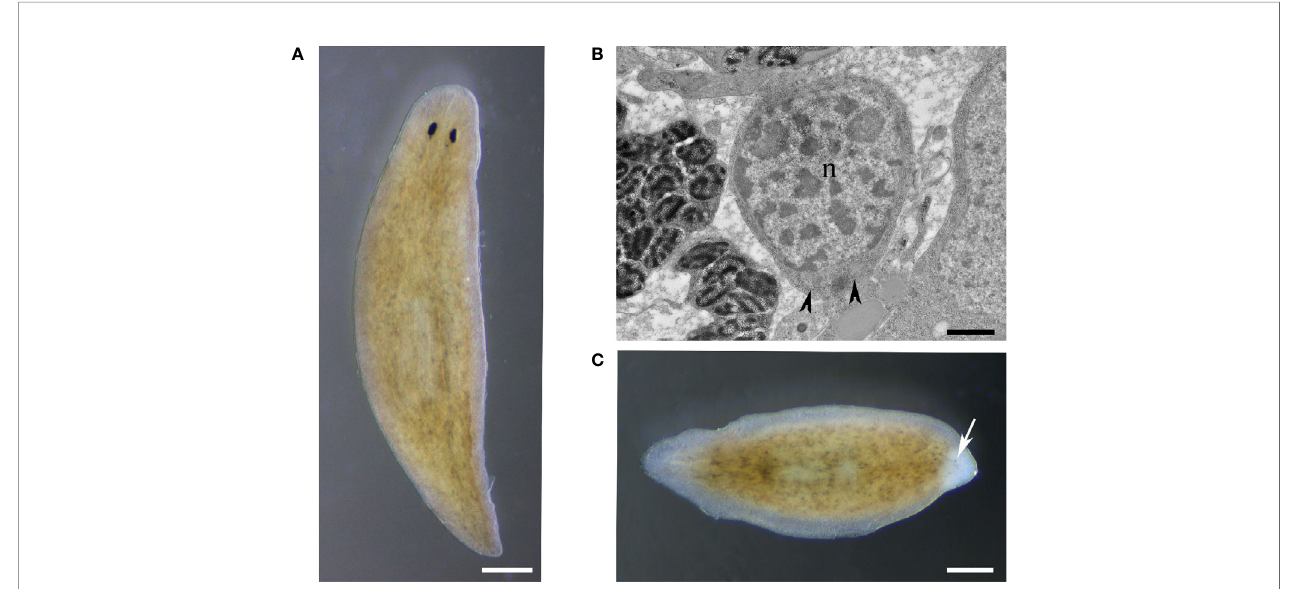
FIGURE 2 | (A) Intact planaria ( Dugesia japonica , asexual GI clone). (B) Electron micrograph of a neoblast, the planarian stem cell, with scanty undifferentiated cytoplasm containing free ribosomes and mitochondria. n, nucleus; arrowhead, mitochondria. (C) A tail fragment is regenerating the head, 3 days after amputation. Arrow indicates the unpigmented blastema containing the new differentiating eye cups. Scale bar: 100 m m in (A, C) , and 800 nm in (B)